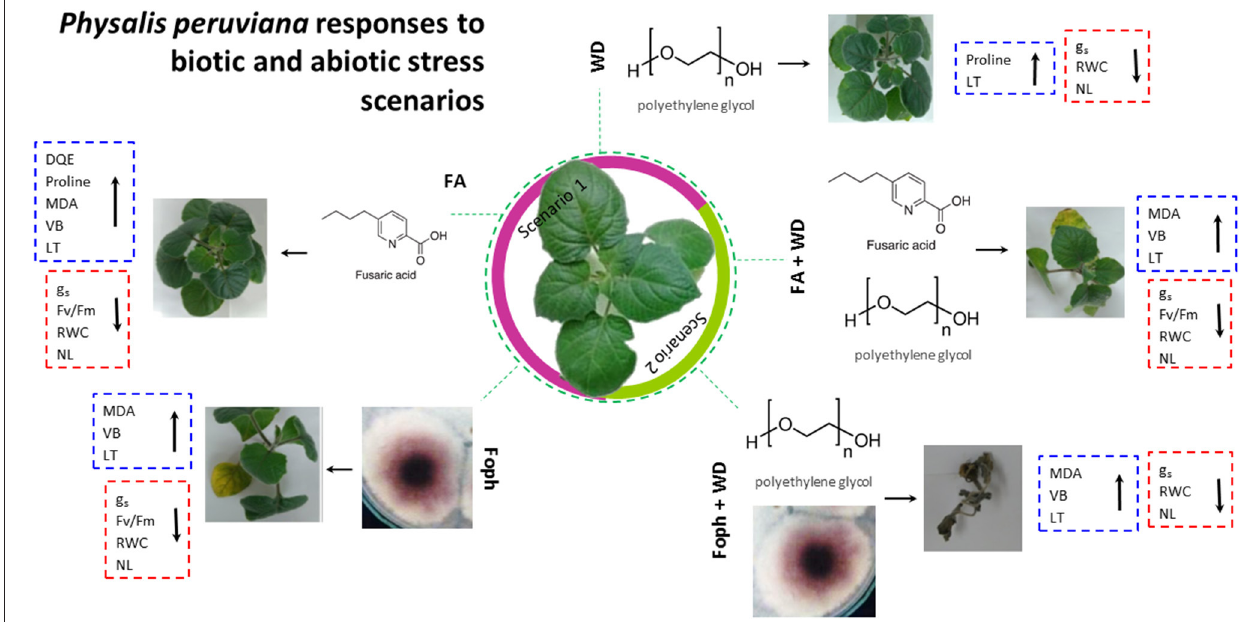
FIGURE 7 | Schematic representation of Physalis peruviana ecotype Colombia responses to Fusarium oxysporum f. sp. physali (Foph) inoculation and water deficit (WD, polyethylene glycol) as potential biotic and abiotic plant stress scenarios. The model includes fusaric acid (FA) as one of the main Fusarium toxins involved in pathogenesis to visualize its role in plant disease development. The central cape gooseberry plant represents a healthy plant. Scenario 1 (purple area) is related to biotic stress caused by Foph and FA. Scenario 2 (green area) includes abiotic stress (WD) and its interaction with FA and Foph. Visual expression of the symptoms followed by plant physiological responses to each stress condition is shown. Physiological parameters that increase and decrease under each stress condition are clustered in red and blue dotted line boxes, respectively. From left to right: responses to (i) Foph Map5 strain, (ii) FA exposure, (iii) WD stress condition, (iv) WD stress condition under FA exposure, and (v) WD stress condition under Foph Map5 presence. VB, vascular browning; g s , stomatal conductance; F v /F m ; quantum yield of photosystem II; DQE, maximum quantum efficiency of PSII; MDA, malondialdehyde; LT, leaf temperature; NL, number of